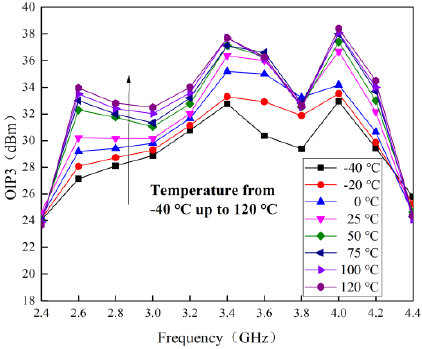
Figure 13. Measured curves of OIP3 at different temperatures.